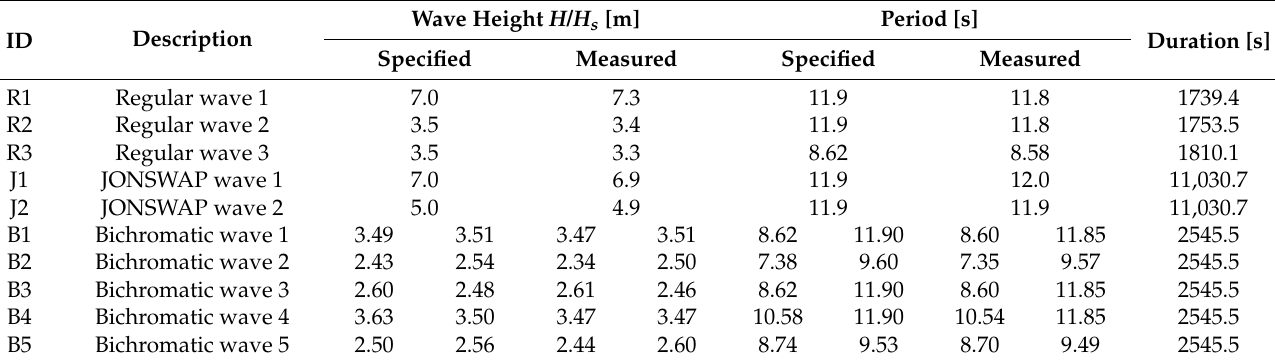
Table 2. Descriptions of all wave conditions (All values at full